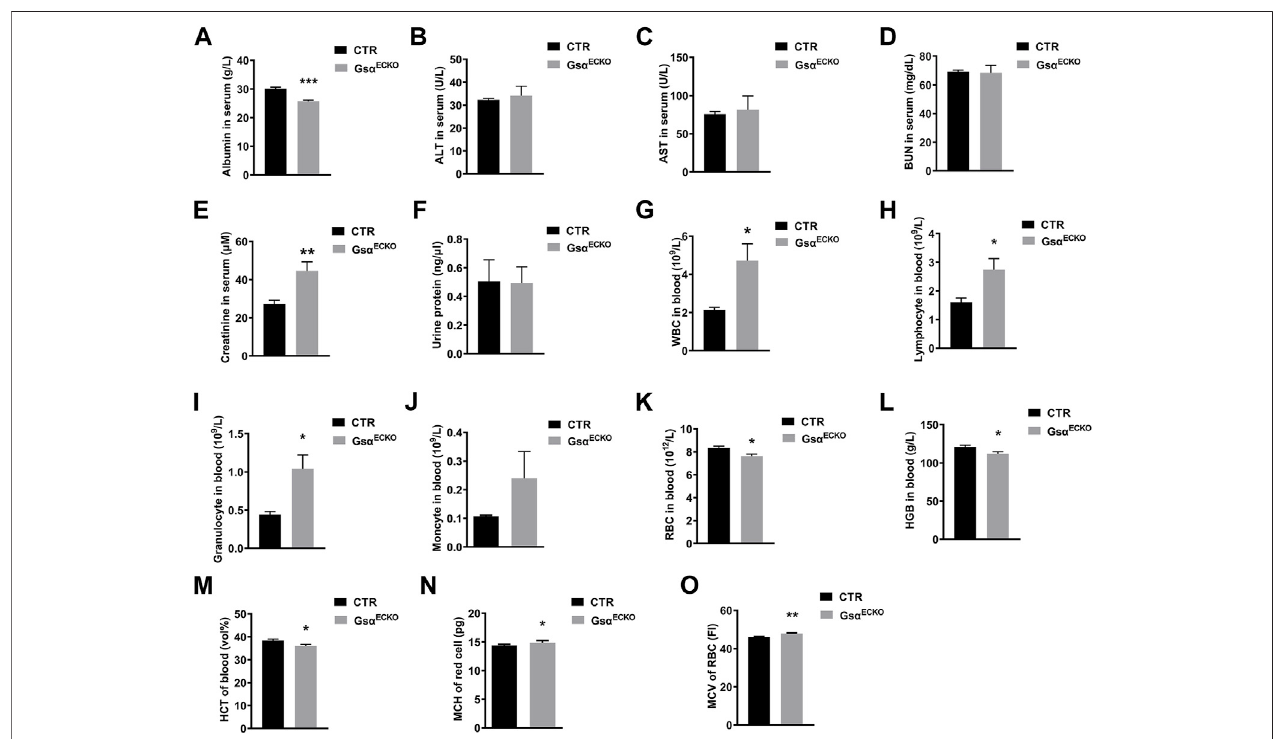
FIGURE 4 | Endothelial Gs α de fi ciency impaired plasma protein homeostasis and disrupted blood composition. (A – E) Quanti fi cation of Albumin, ALT, AST, BUN, and Creatinine in blood serum of CTR and Gs α ECKO mice. n = 5 to 6 per group. (F) Quanti fi cation of protein in the urine of CTR and Gs α ECKO mice. n = 5 to 6 per group. (G – K) Quanti fi cation of white blood cells (WBC), Lymphocyte, Granulocyte, Monocyte, and red blood cells (RBC) in the blood of CTR and Gs α ECKO mice. n = 5 to 6 per group. (L – M) Quanti fi cation of hemoglobin (HGB) and (red blood cell-speci fi c volume) HCT in blood of CTR and Gs α ECKO mice. n = 5 per group. (N – O) Mean corpuscularhemoglobin(MCH)andmeancorpuscularvolume(MCV)ofredbloodcellsofCTRandGs α ECKO mice. n =5to6pergroup.Dataareshownasmean±SEM. * p < 0.05; ** p < 0.01; *** p < 0.001 between 2 indicated groups by 2-tailed Student